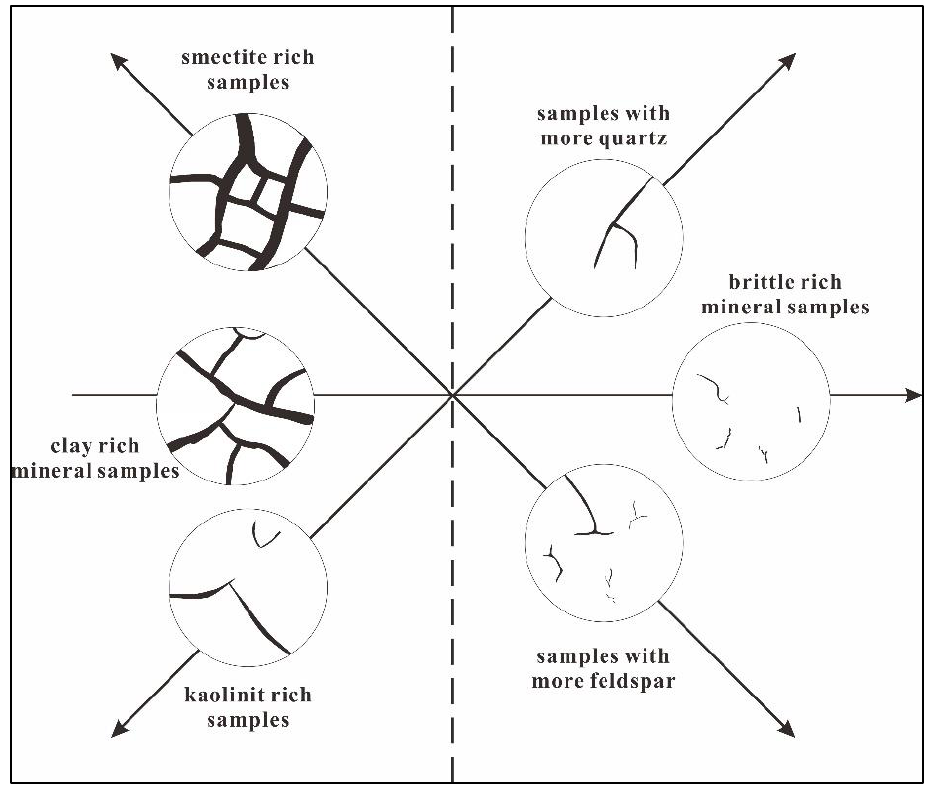
Figure 14. Desiccation crack morphological prediction diagram for various mineral compositions. The arrows indicate that the mineral ratio is increasing. The x-axis is the content ratio of brittle minerals to clay minerals. In the negative half axis of the x-axis, the y-axis shows the content ratio of smectite to kaolin. In the positive half axis of the x-axis, the y-axis shows the content ratio of quartz to feldspar. Table 8. Morphological parameters of samples at the scale of per dm 2 .